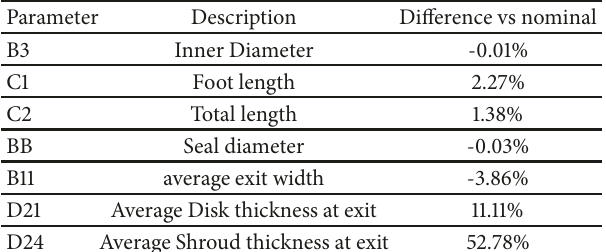
Table 7: Impeller dimensions outside requested